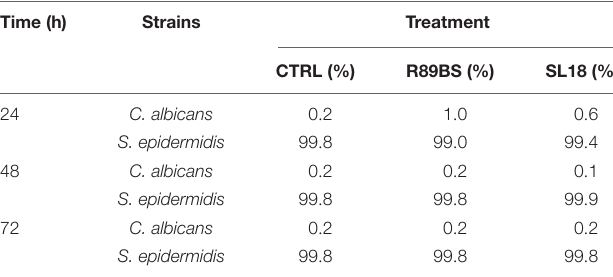
TABLE 4 | Percentage (%) composition of C. albicans – S. epidermidis dual-species biofilms on the surface of silicone